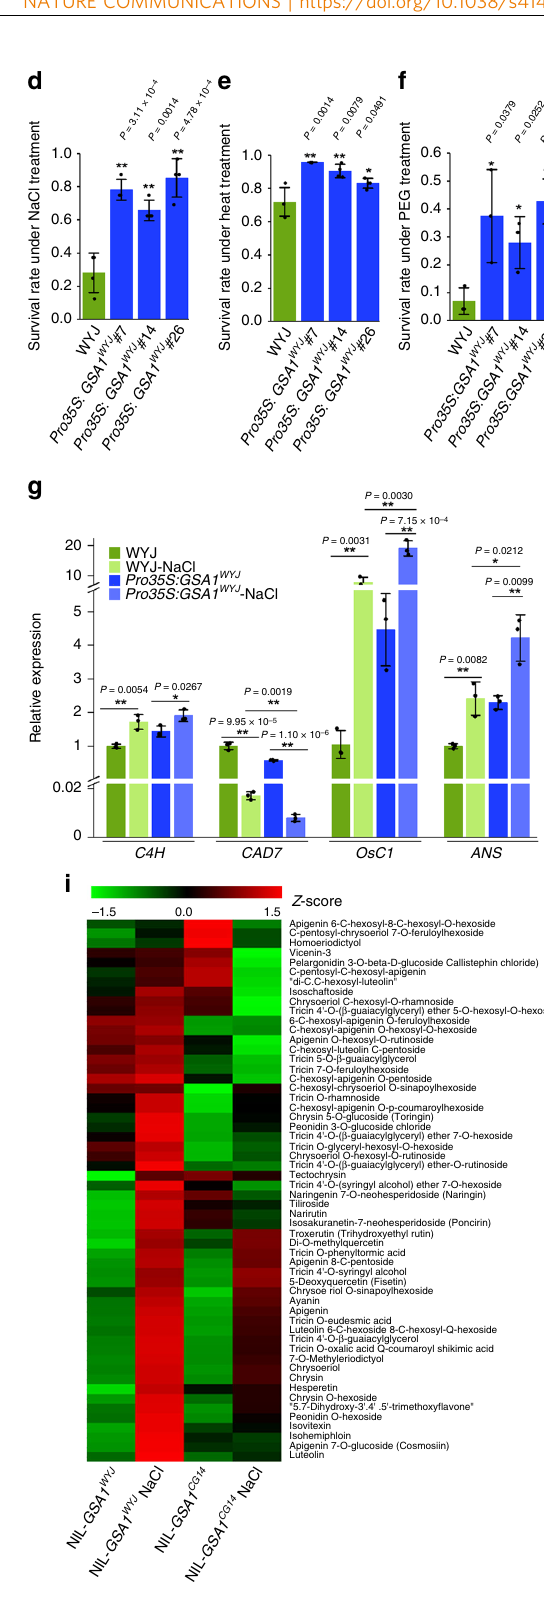
enhanced abiotic stress tolerance in Pro35S:GSA1 WYJ seedlings. Taken together, we conclude that GSA1 plays a key role in the induction of central phenylpropanoid pathway and fl avonoid biosynthesis pathway, as well as in the redirection of metabolic fl ux from the lignin pathway to the fl avonoid biosynthesis pathway in response to abiotic stress.